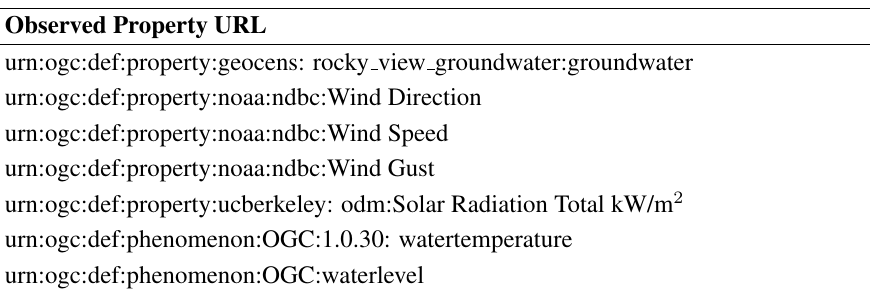
Table 3. Example property